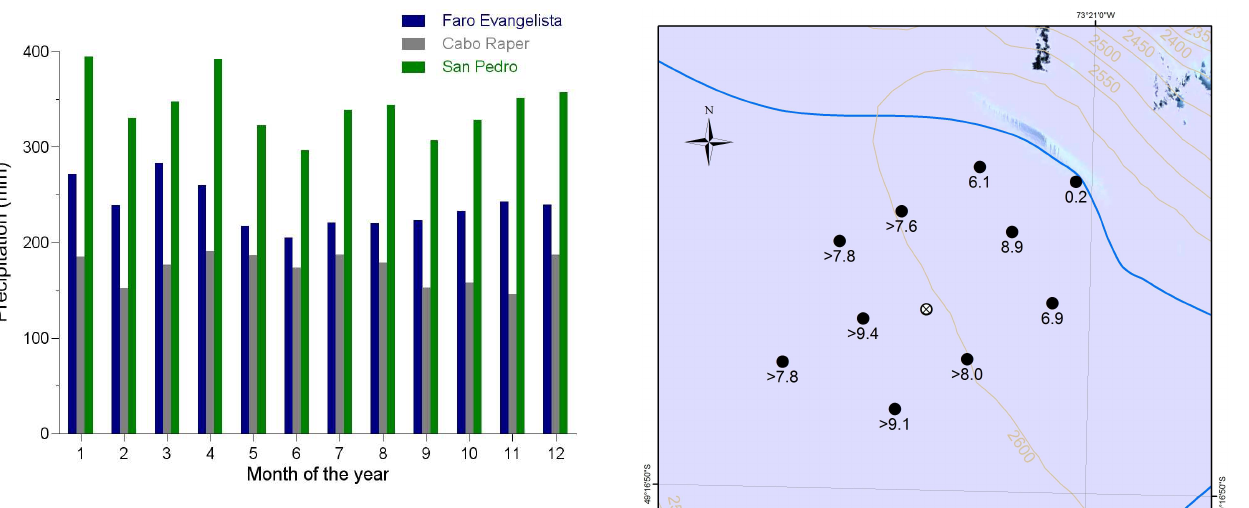
Fig. 6. Monthly averaged precipitation at the coastal sites Cabo Raper (46°48’12’’S,